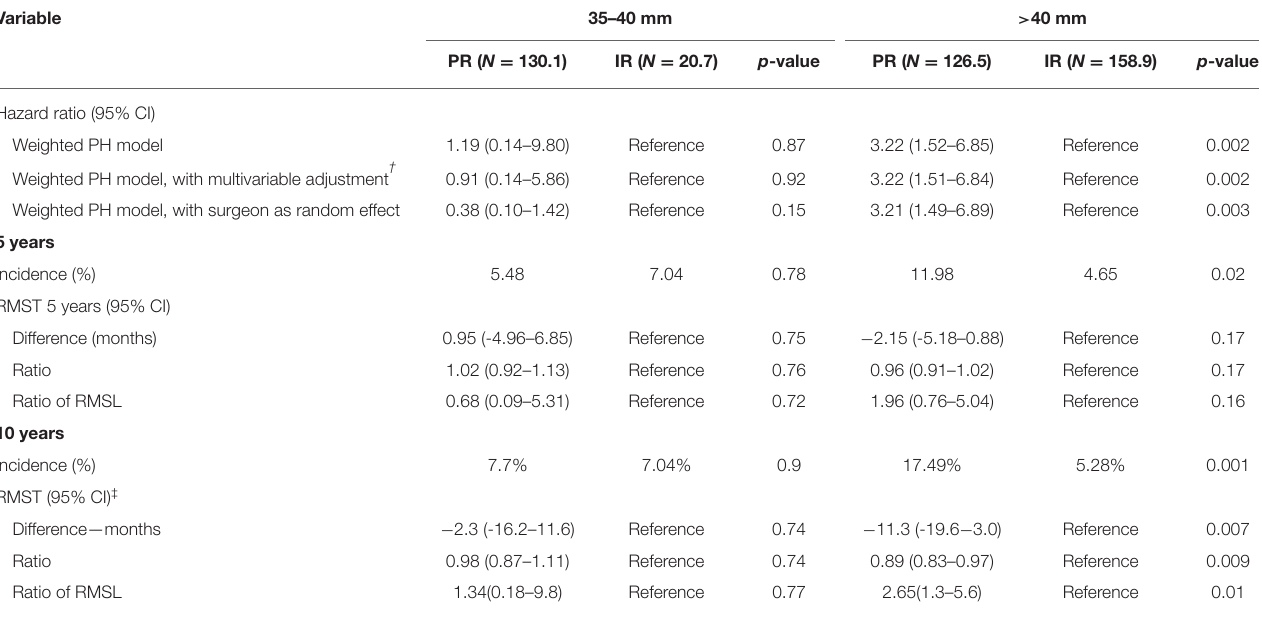
TABLE 2 | Diameter-group differences in primary endpoints in “valve